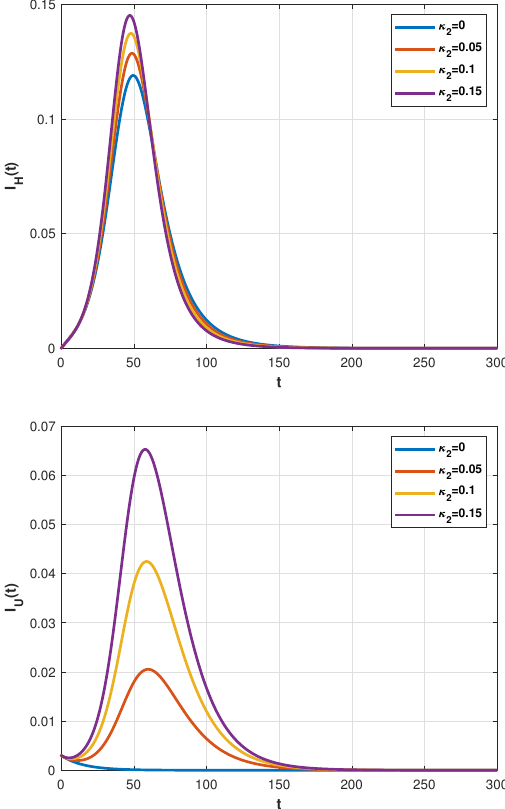
Fig. 8: Number of infected populations for different values of κ 2 , where other parameters are fixed κ 1 = 0 . 3 , α 1 = 2 , α 2 = 3 , ε 1 = 0 . 67 , ε 2 = 0 . 06 , ε 3 = 0 . 06 , µ H = 0 . 00004 , µ V = 0 . 07 , µ U = 0 . 07 , β 1 = 0 . 35 , β 2 = 0 . 9 , λ = 0 . 235 , γ = 0 . 16 , θ 1 = 0 . 33 , θ 2 = 0 . 3